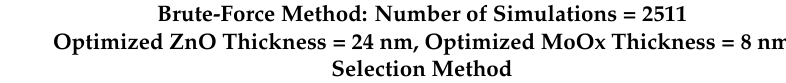
Table 3. Comparison results for multi-layer optimization.